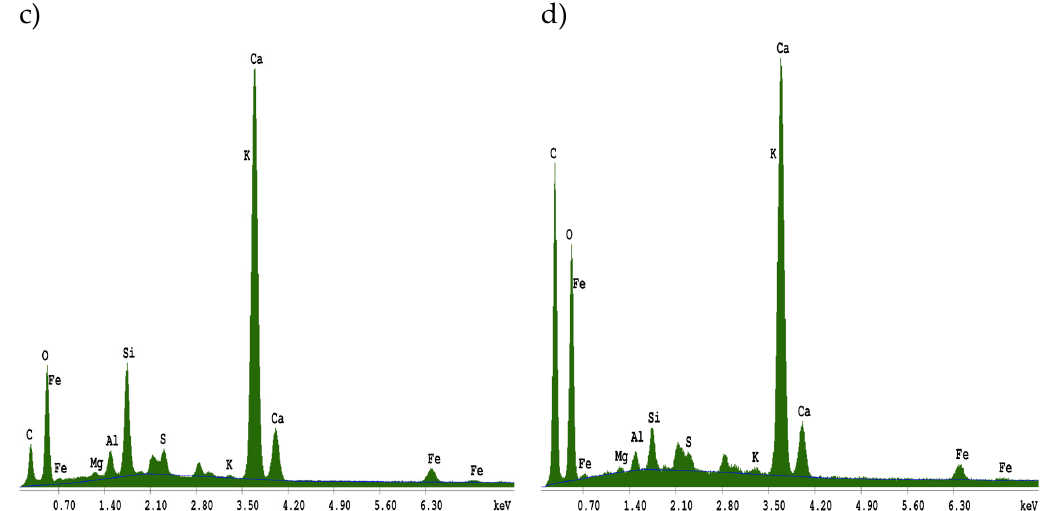
Figure 6. Results obtained using the energy dispersive X-ray spectroscopy (EDS) analyzer for board C: ( a ) areas of elemental composition analysis, ( b ) results of EDS in point 1, ( c ) results of EDS in point 2, ( d ) results of EDS in point 3.